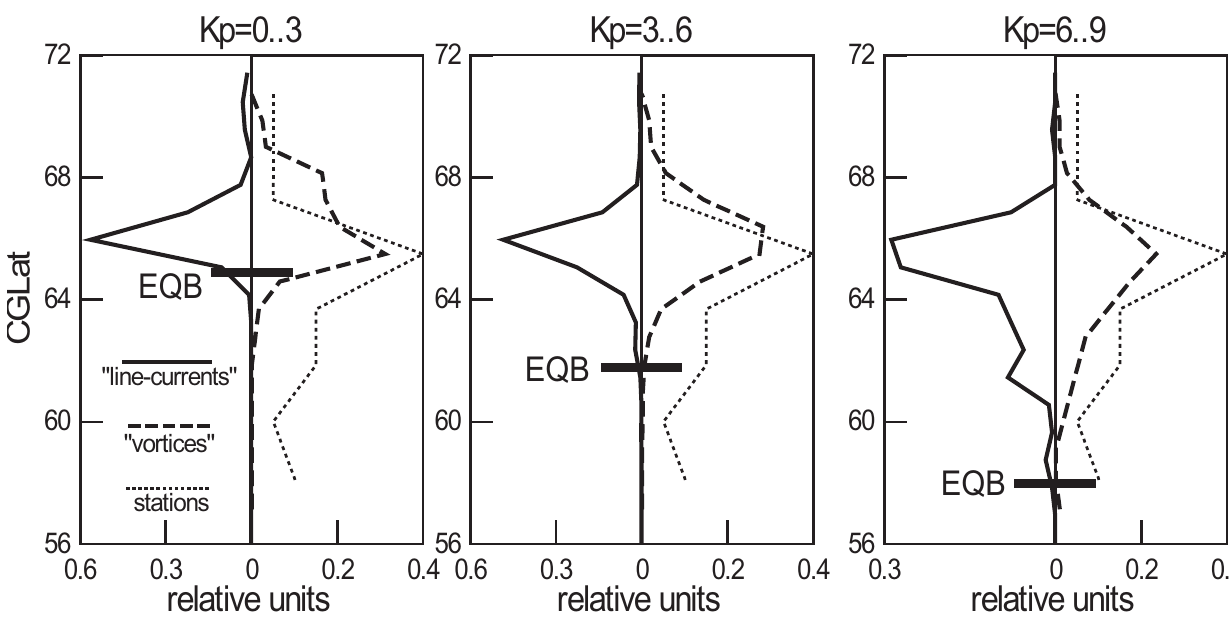
Fig. 7. Latitudinal distributions of AEJ-dominated (solid line) and vortex-dominated (dashed line) current systems. The distinction criterion as in Sect. 3.2 is applied. The latitudinal distribution of magnetometer locations is also shown for reference (dotted line). Equatorward boundary (EQB) of the auroral oval for the morning sector at MLT 4–6h is shown by horizontal ticks, its latitude near midnight would be ∼ 2 ◦ equatorward (after Starkov,